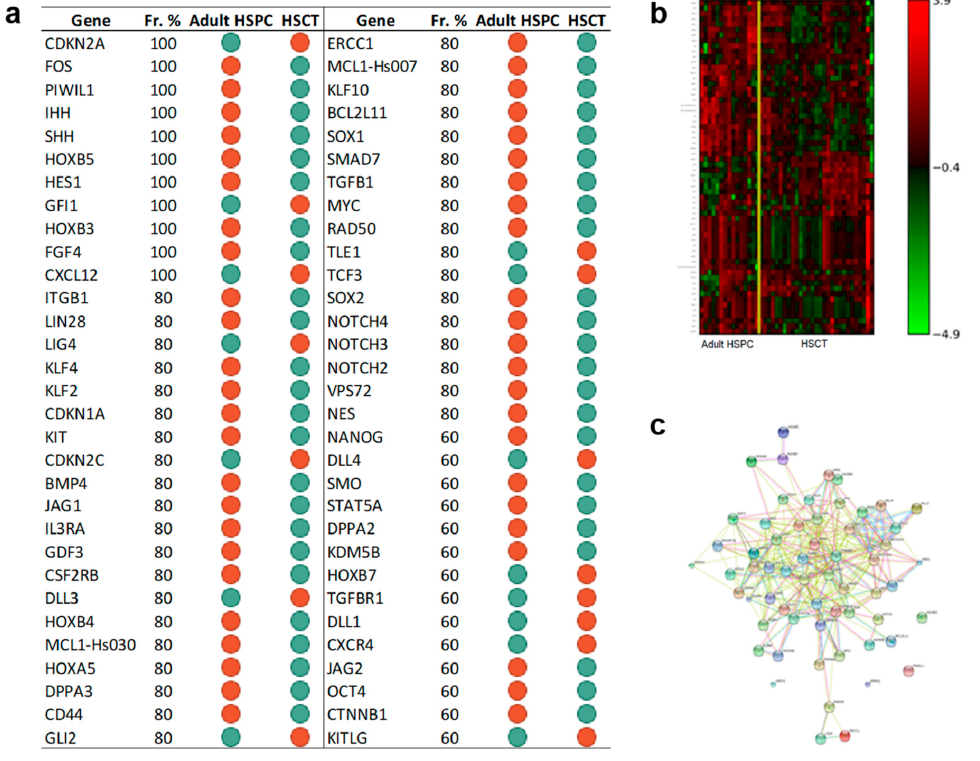
Figure 6. The results indicated that a signature of 62 genes can discriminate adult CD34+ cells before and after transplantation. Further, KEGG enrichment underlined the role of NOTCH and Hedgehog pathways. Panel a : Gene Signature. List of 62 gene symbols selected by the l 1 l 2FS procedure. For each gene, we report the corresponding frequency percentage score and the gene expression relative to the comparison between indicated groups: Green dots, downregulation; red dots, upregulation. Panel b : Heatmap associated with the 62 genes of the signature discriminating between adult HSPC (15 samples) and adult and pediatric after HSCT (29 samples). The expression data for each gene has been scaled and is represented by pseudo-colors in the heatmap. Red color corresponds to a high level of expression and green color corresponds to a low level of expression as also shown in the color bar. Panel c : Association network of the genes in the signature between adult HSPC (15 samples) and adult and pediatric after HSCT (29 samples) inferred by the STRING online tool. The identified connections are of five different types: Text mining (lime green), Experiments (magenta), Databases (Turquoise), Coexpression (Black), Homology (purple).